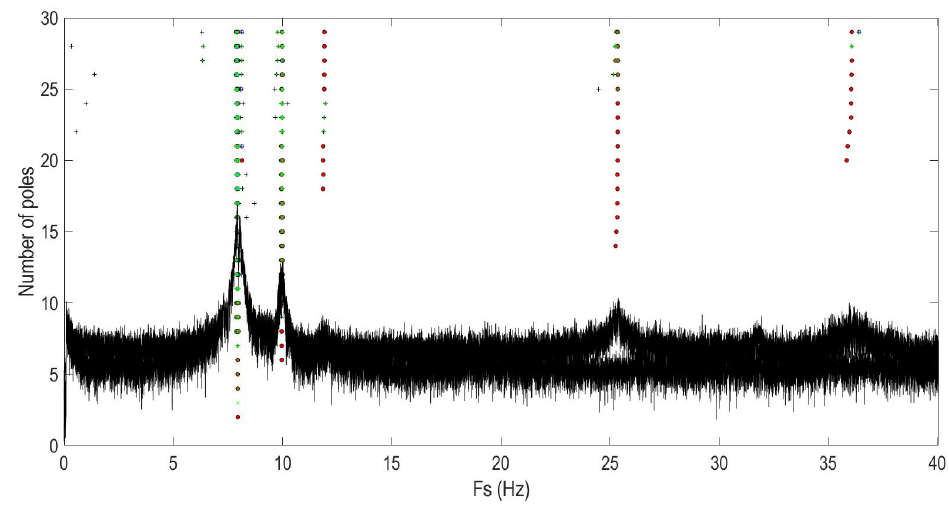
Figure 9. Stabilization diagram of the identified eigenfrequencies calculated with the SSI-cov.